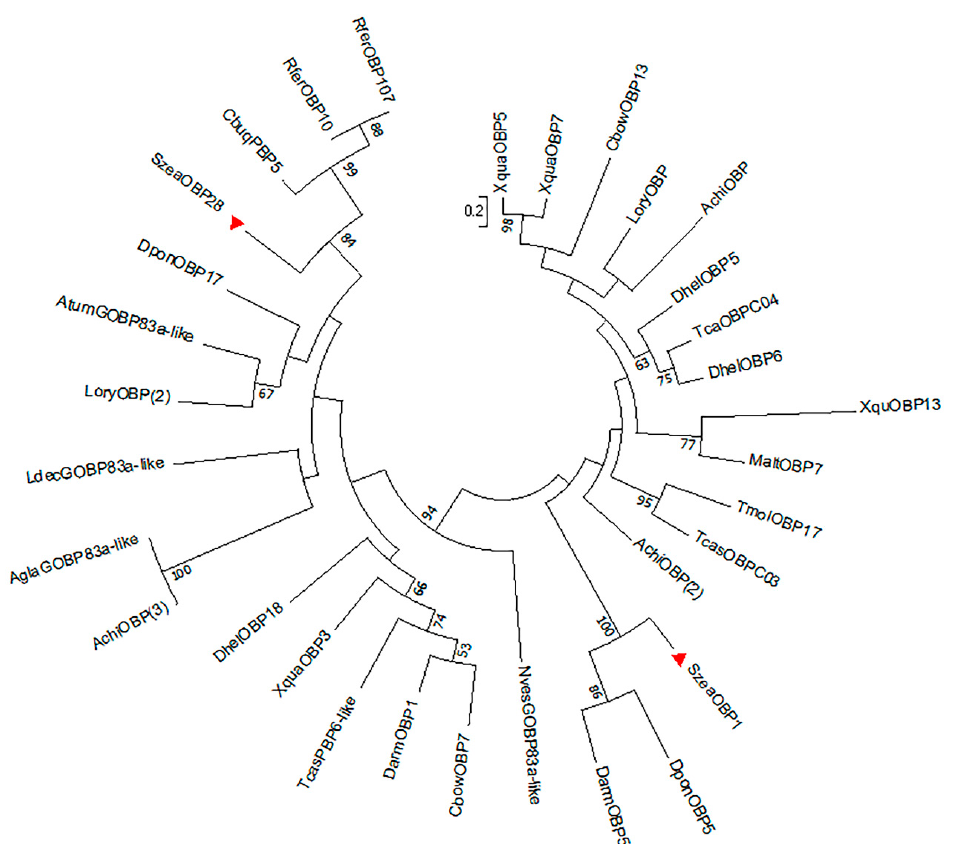
Figure 3. Maximum likelihood tree of 32 OBPs from Sitophilus zeamais and other Coleopteran insects with 1000 bootstrap replicates. The species names and GenBank accession numbers for all the OBP sequences as follows: Aethina tumida (AtumGOBP83a-like, XP_019868892.1); Anoplophora chinensis